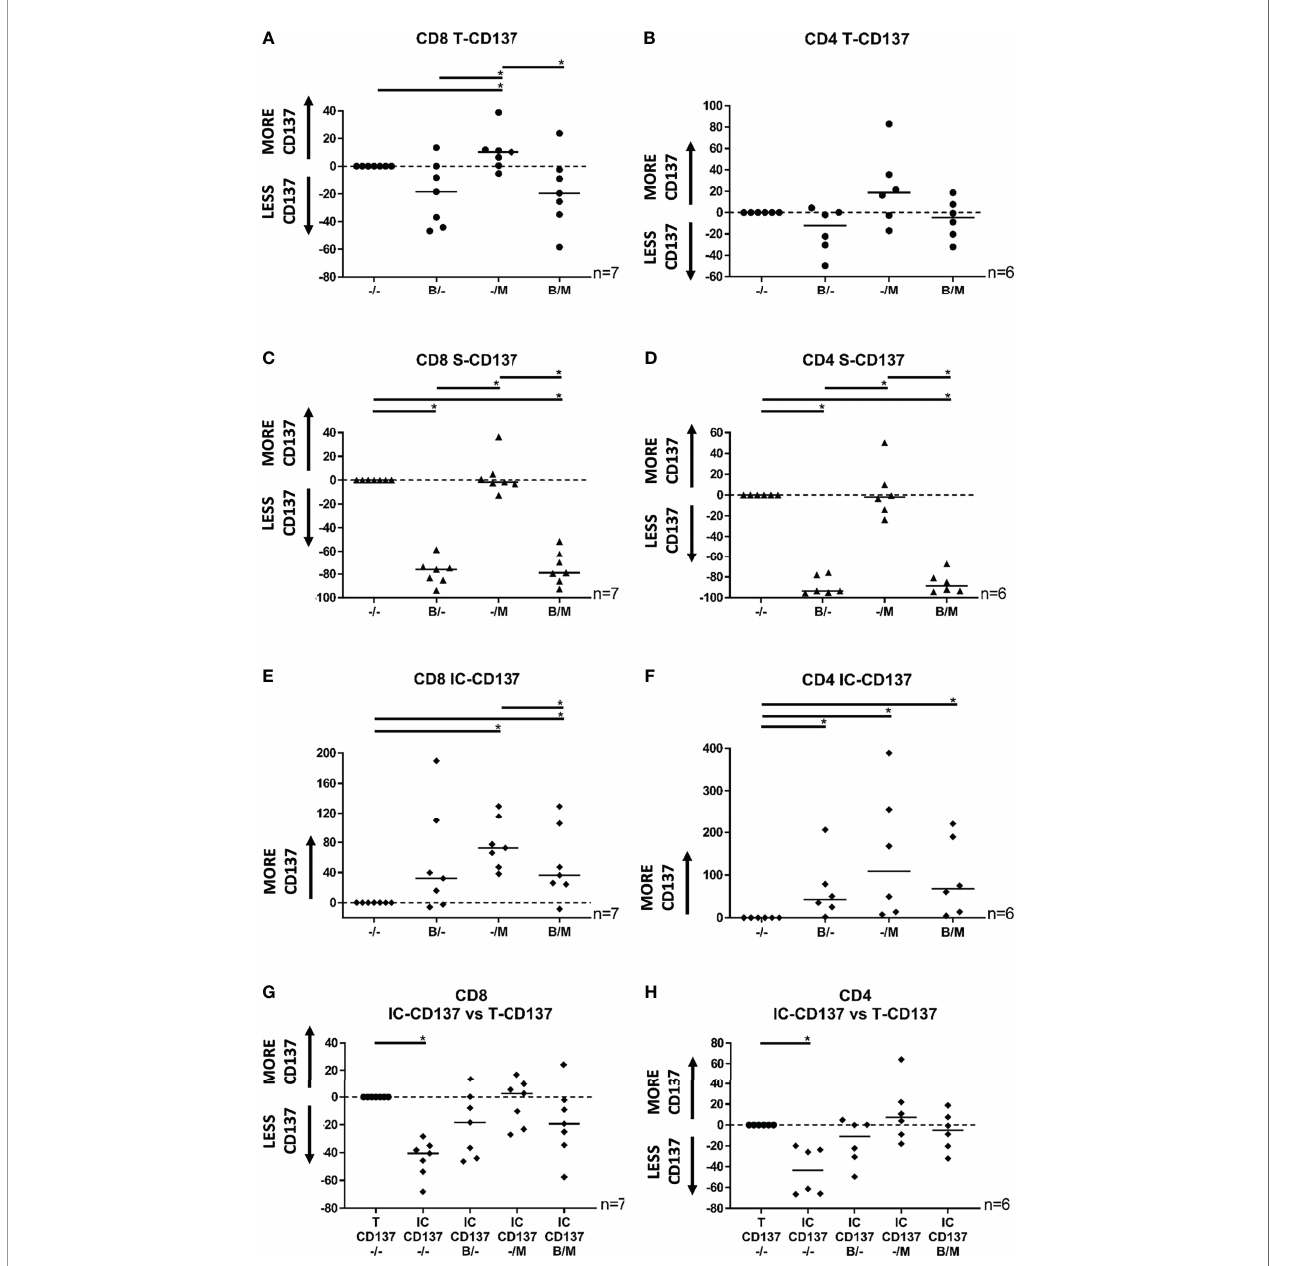
FIGURE 1 | Scatter plots showing the total, surface, and intracellular expression of CD137 in CD8 + and CD4 + TILs following 8 hours of co-culture with autologous tumor cells. (A) Total CD137 expression in CD8 + TILs in the presence of BFA, MN, or the combination of BFA and MN was modulated by -18%, +10%, and -19%, respectively. (B) Total CD137 expression in CD4 + TILs in the presence of BFA, MN, or the combination of BFA and MN was modulated by -12%, +19%, and -5%, respectively. (C) Surface CD137 expression in CD8 + TILs in the presence of BFA, MN, or the combination of BFA and MN was modulated by -76%%, -2%, and -79%, respectively. (D) Surface CD137 expression in CD4 + TILs in the presence of BFA, MN, or the combination of BFA and MN was modulated by -94%, -2%, and -88%, respectively. (E) Intracellular CD137 expression in CD8 + TILs in the presence of BFA, MN, or the combination of BFA and MN was modulated by +32%, +73%, and +36%, respectively. (F) Intracellular CD137 expression in CD4 + TILs in the presence of BFA, MN, or the combination of BFA and MN was modulated by median +43%, +109%, and +68%, respectively. (G, H) Intracellular CD137 expression in (G) CD8 + TILs and (H) CD4 + TILs in the presence of BFA, MN, or the combination of BFA and MN was not signi fi cantly reduced in comparison to the total CD137 expression. TIL activation was de fi ned as the percentage of live T cells staining positive for either surface expression of CD137 (S-CD137), intracellular expression of CD137 (IC-CD137), or at least one form of CD137 (Total CD137 or T- CD137), minus control (TILs alone). Normalized values relative to the relevant (surface, intracellular or total) CD137 expression in the absence of BFA and MN (-/-) are shown in the dot plots. Bulk MM TIL samples were used for these analyses. *p < 0.05; M, monensin, MN; B, brefeldin A,